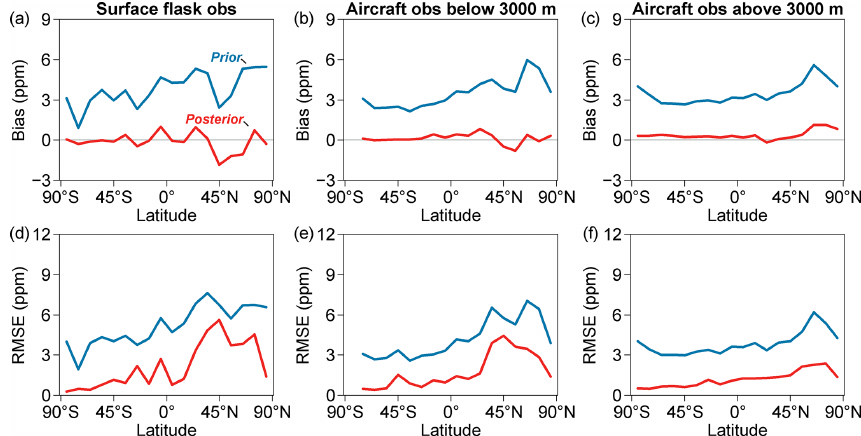
Figure 8. Comparisons of GEOS-Chem-modeled dry-air mole fractions of CO 2 with surface and aircraft measurements. The simulations driven by the prior (blue curves) and posterior (red curves) fluxes of our reference inversions between 2015 and 2020 were evaluated against surface flask observations (a, d) , aircraft observations obtained below 3000ma.s.l. (b, e) , and aircraft observations obtained above 3000m (c, f) to derive the model biases (a–c) and RMSEs (d–f) . The surface and aircraft measurement programs are summarized in Tables S1 and S2,